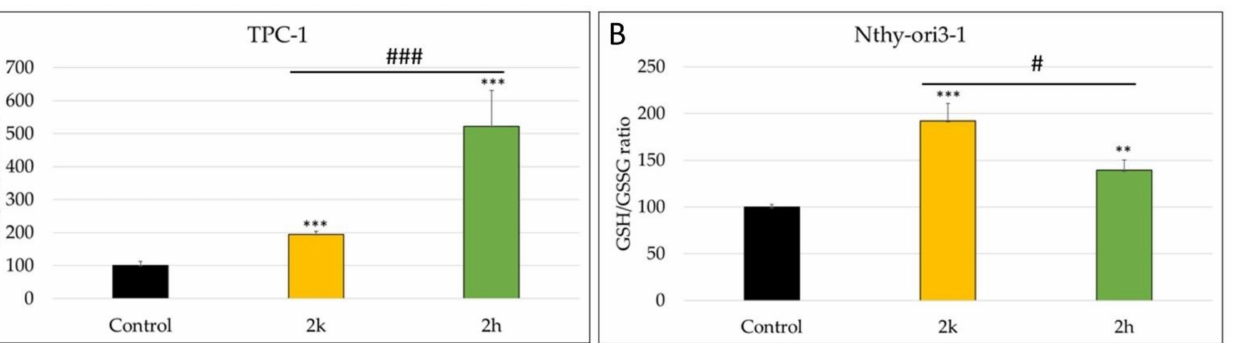
Figure 4. Effects of coumarins 2k and 2h on intracellular levels of GSH/GSSG ratio. ( A , B ): Graphs illustrate GSH/GSSG levels (%) in thyroid cancer cell line TPC-1 ( A ) and thyroid normal cells Nthy-ori- 1-3 ( B ) compared with each group of control (untreated) cells. Peak areas of intracellular aminothiols were normalized using protein contents (ng of aminothiols per µ g of proteins) and expressed as the percentage of the ratio of reduced and oxidized forms of the untreated cells (control, 100%). Data are expressed as mean ± SD. All experiments were performed three times independently, each time in triplicate to confirm the results. Statistical analysis was performed by Student t -test. ** = p < 0.01 and *** = p < 0.001, respectively, for 2k and 2h vs. control. # = p < 0.05 and ### = p < 0.001 2k vs. 2h